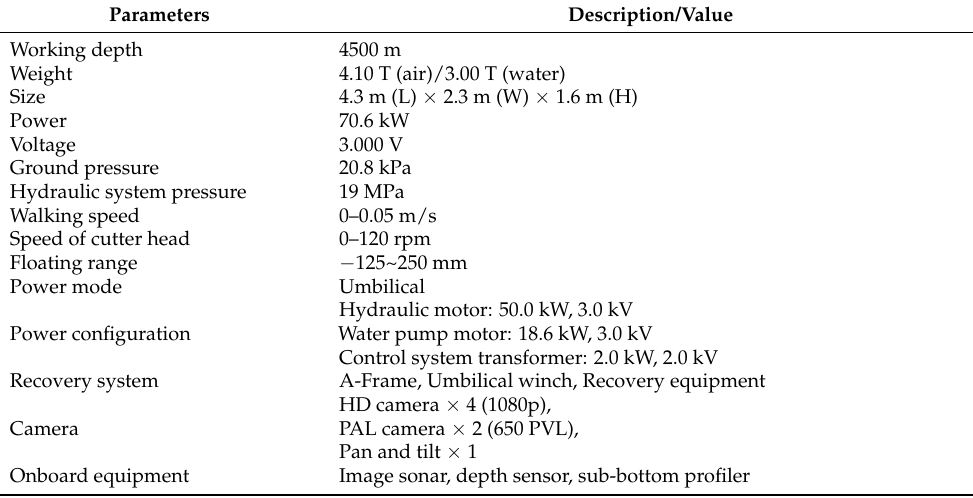
Table 10. Vehicle Table 10. Vehicle specifications.